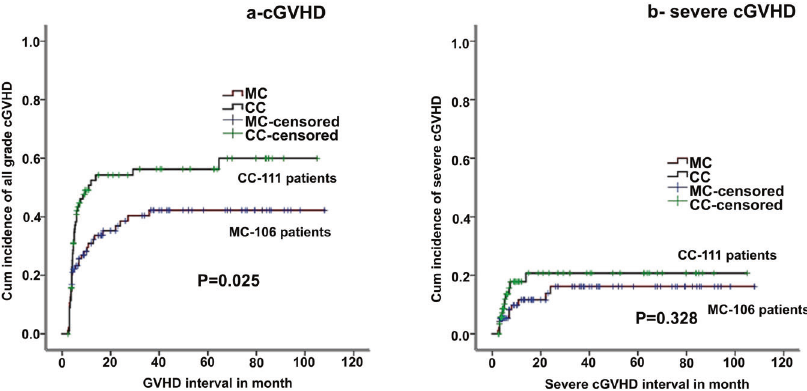
Fig. 3 Comparison of cGVHD between CC and MC. a Cumulative incidence of all grade cGVHD (CC complete chimerism, MC mixed chimerism). b Cumulative incidence severe grade cGVHD (CC complete chimerism, MC mixed chimerism).